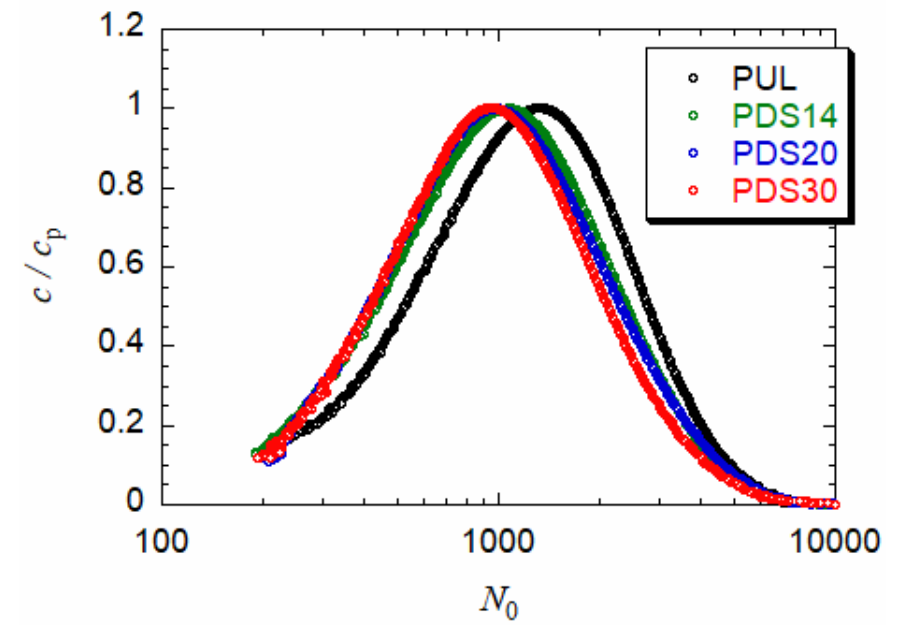
Figure 1. Elution curves (the polymer mass concentration c divided by the peak concentration c p ) and elution time dependences of the degree of polymerization N 0 and the radius of gyration (cid:104) S 2 (cid:105) 1/2 for a PUL-OSA sample (PDS30) and PUL in 0.01 M aqueous NaCl.